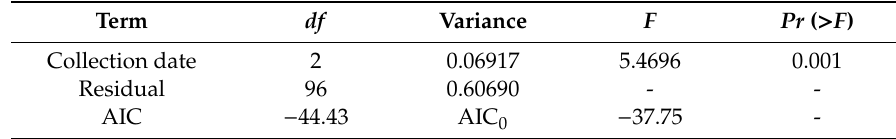
Figure 2. RDA analysis of mite community species composition. Each point represents the community from litterbags per plot per date. Red labels indicate the centroids of factors constraining analysis results (significance test Table 2). Black labels indicate scores of species which occurred at least 10 times among the 16 species; names are first four letters of genera name and first four letters of the species name. Table 2. PERMANOVA test of the influence of litter identity and collection date on mite species communities in RDA reduced space. AIC 0 refers to the null model (unconstrained analysis).